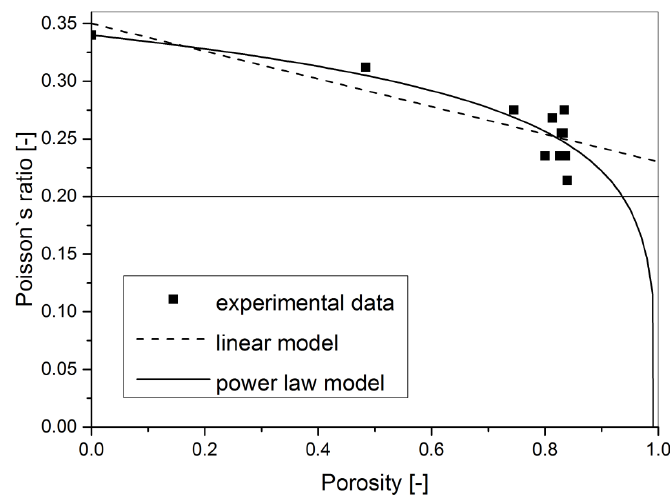
Figure 3. The porosity dependence of Poisson’s ratio of pure aluminium foams. Plotted are the linear model, the power law model, and also the 0.2 constant.